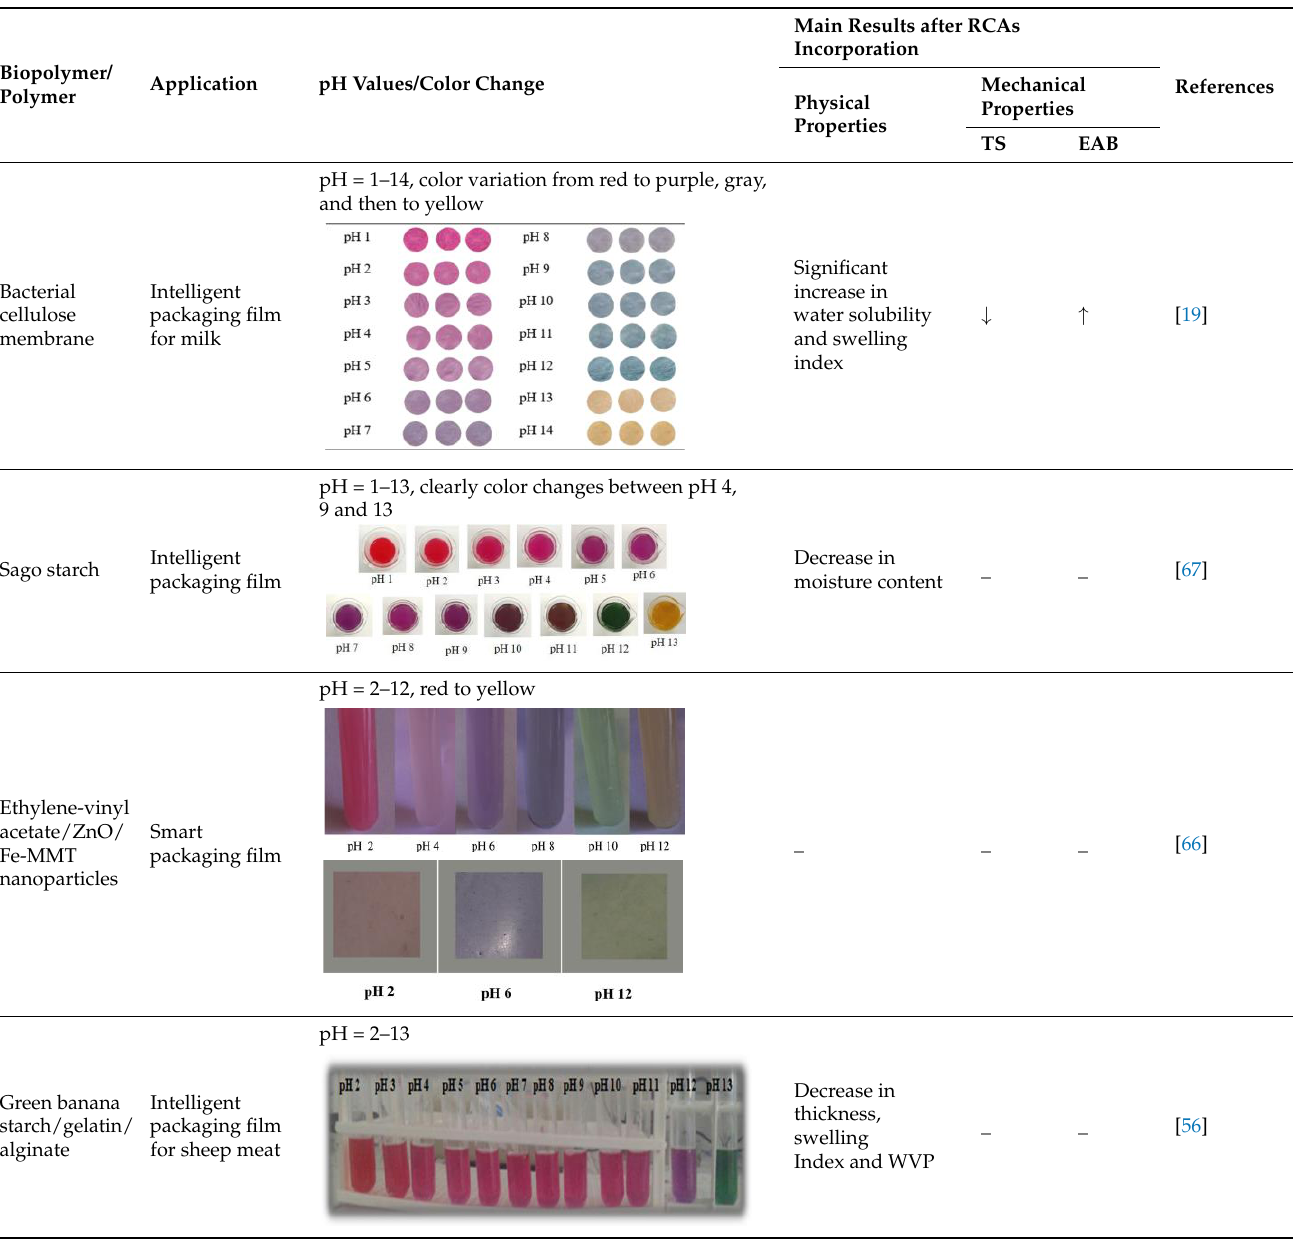
Table 1. Halochromic composite films based on red cabbage anthocyanin: physical and mechanical changes.